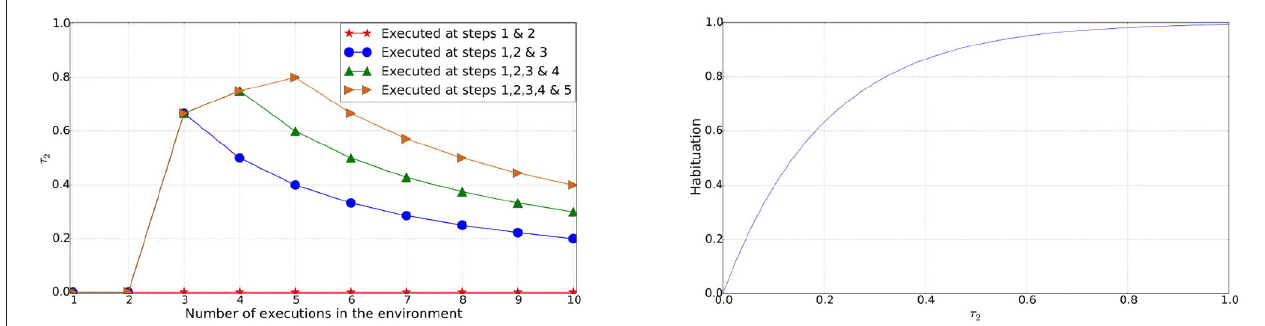
FIGURE 2 | Left : Value of τ 2 for an object perception in schemas used in execution steps [1 & 2], [1, 2 & 3], [1, 2, 3 & 4], and [1, 2, 3, 4 & 5] against the execution steps. Right : Habituation of an object (perception) over the range of values for τ 2